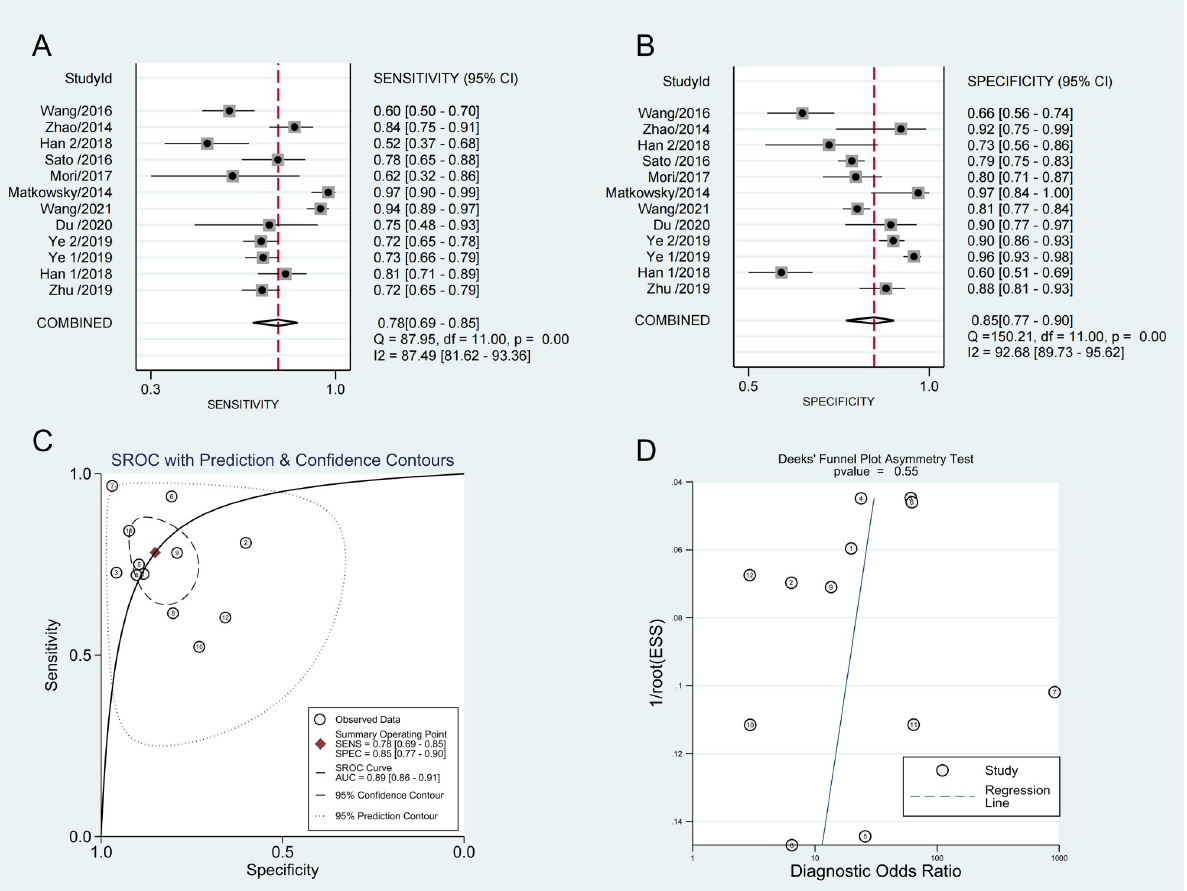
Fig 3. Forest plots of sensitivity (A), specificity (B), area under the curve (AUC) (C), and funnel plot (D) of AKR1B10 for diagnosing HCC among 11 studies.